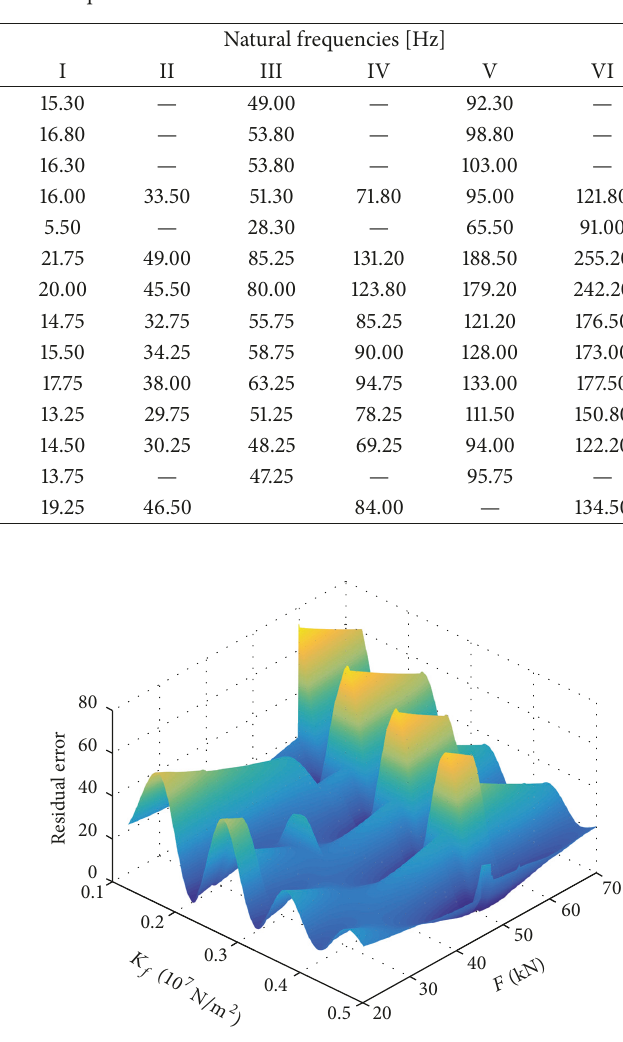
Table 1: Experimental acquisitions.